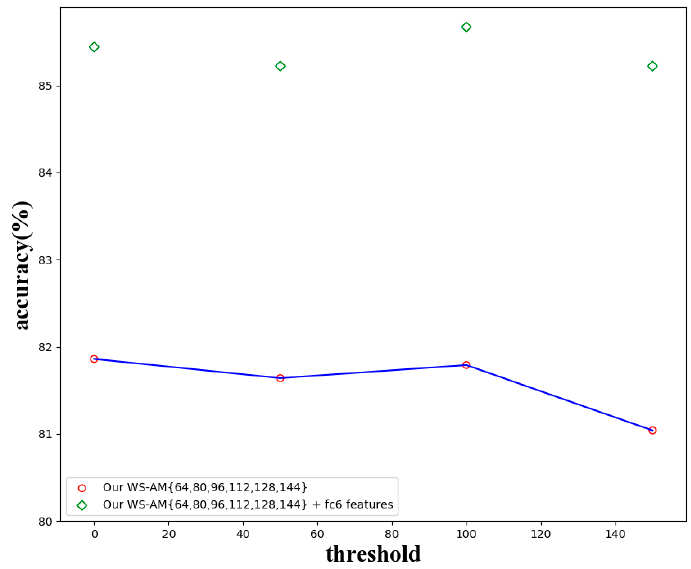
Figure 10. The recognition accuracies of different thresholds on MIT indoor 67 dataset.